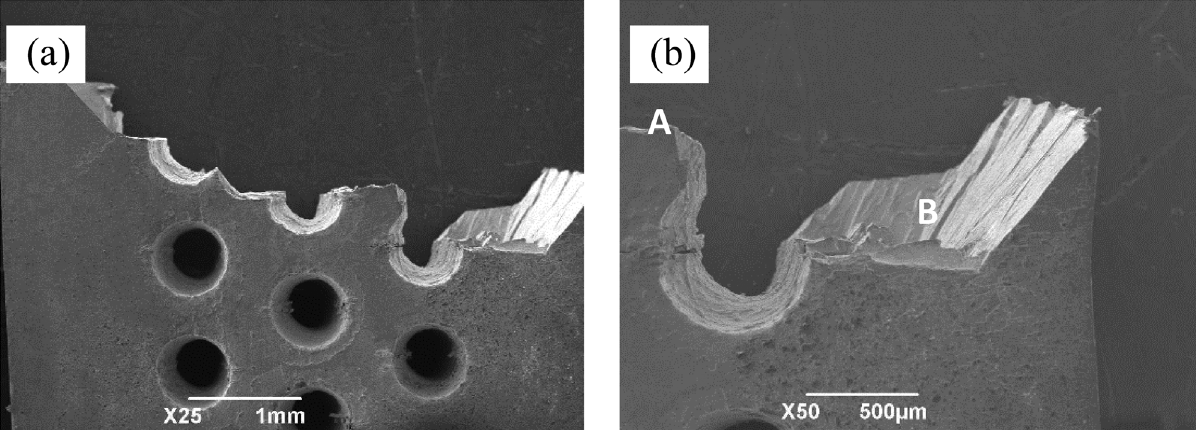
Figure 6: Macroscopic fracture morphology of MSLD specimen: ( a ) fracture pro fi le and ( b ) fracture surface near the